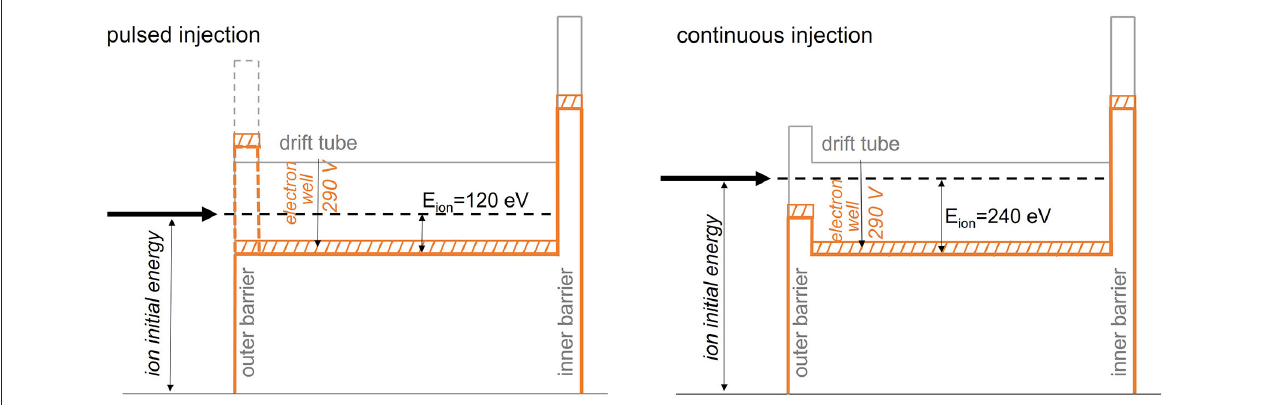
FIGURE 9 | Schematic drawing of potentials for pulsed and continuous injection into the EBIS. The dashed region indicates the radial potential depth of the electron beam, in this case